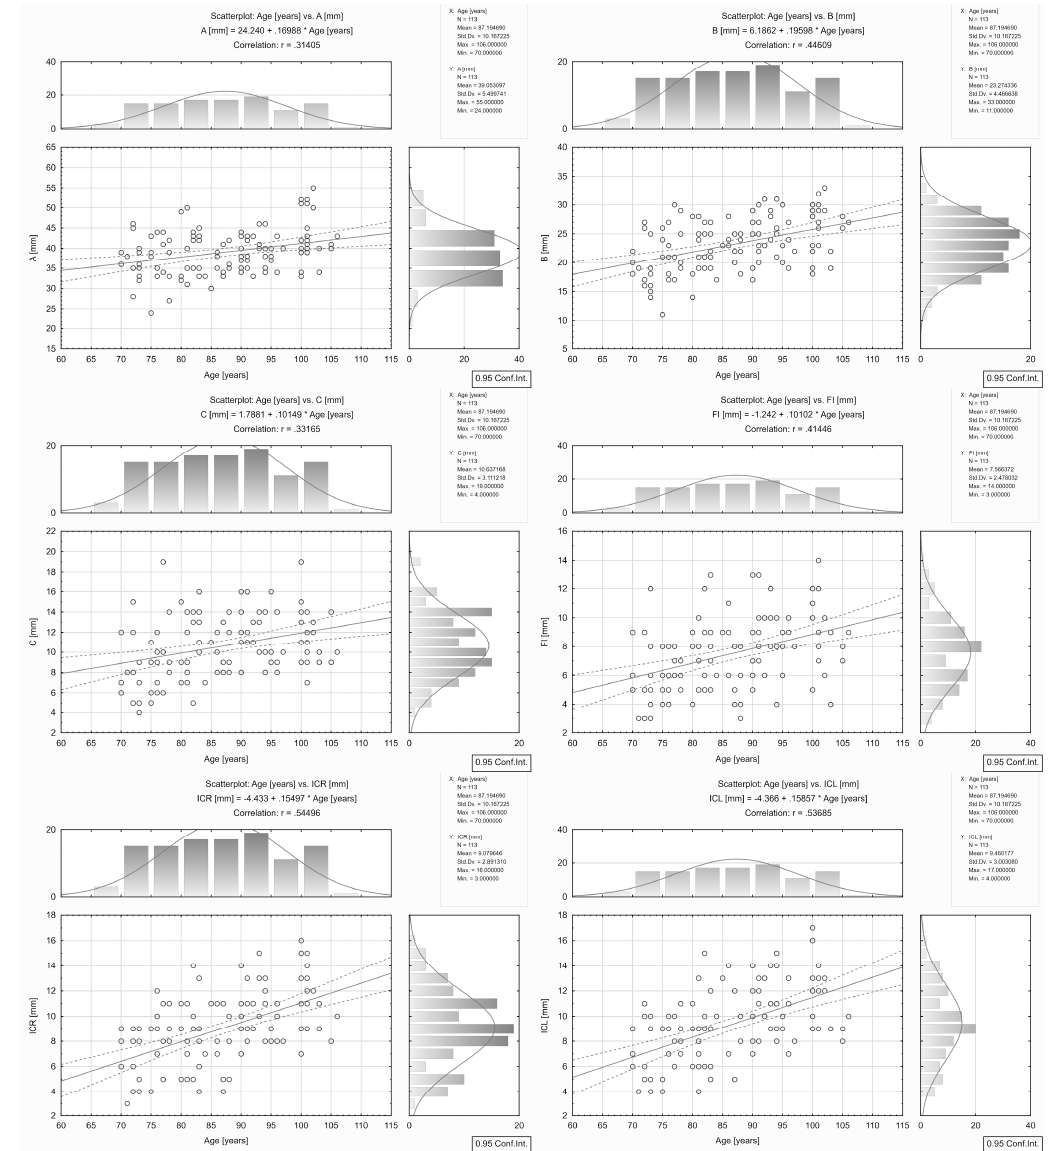
Figure 2. Correlations between brain atrophy parameters/indices: A, B, C, FI, ICR, ICL, and age in the group of all the patients aged 70–106.